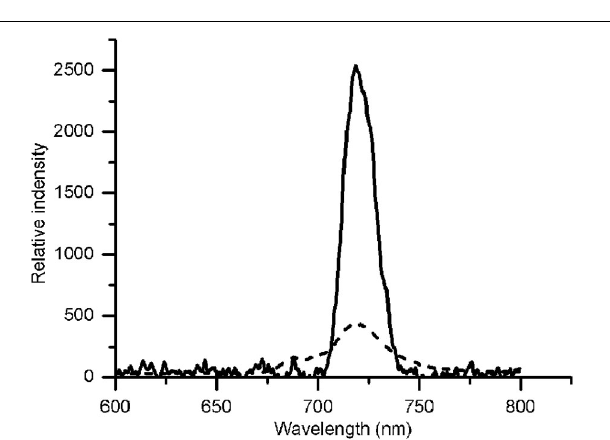
FIGURE 6 | 77 K fluorescence emission spectra of C. nivalis at 22 ◦ C and 4 ◦ C. Broken line, 22 ◦ C- C. nivalis. Solid line, 4 ◦ C- C.